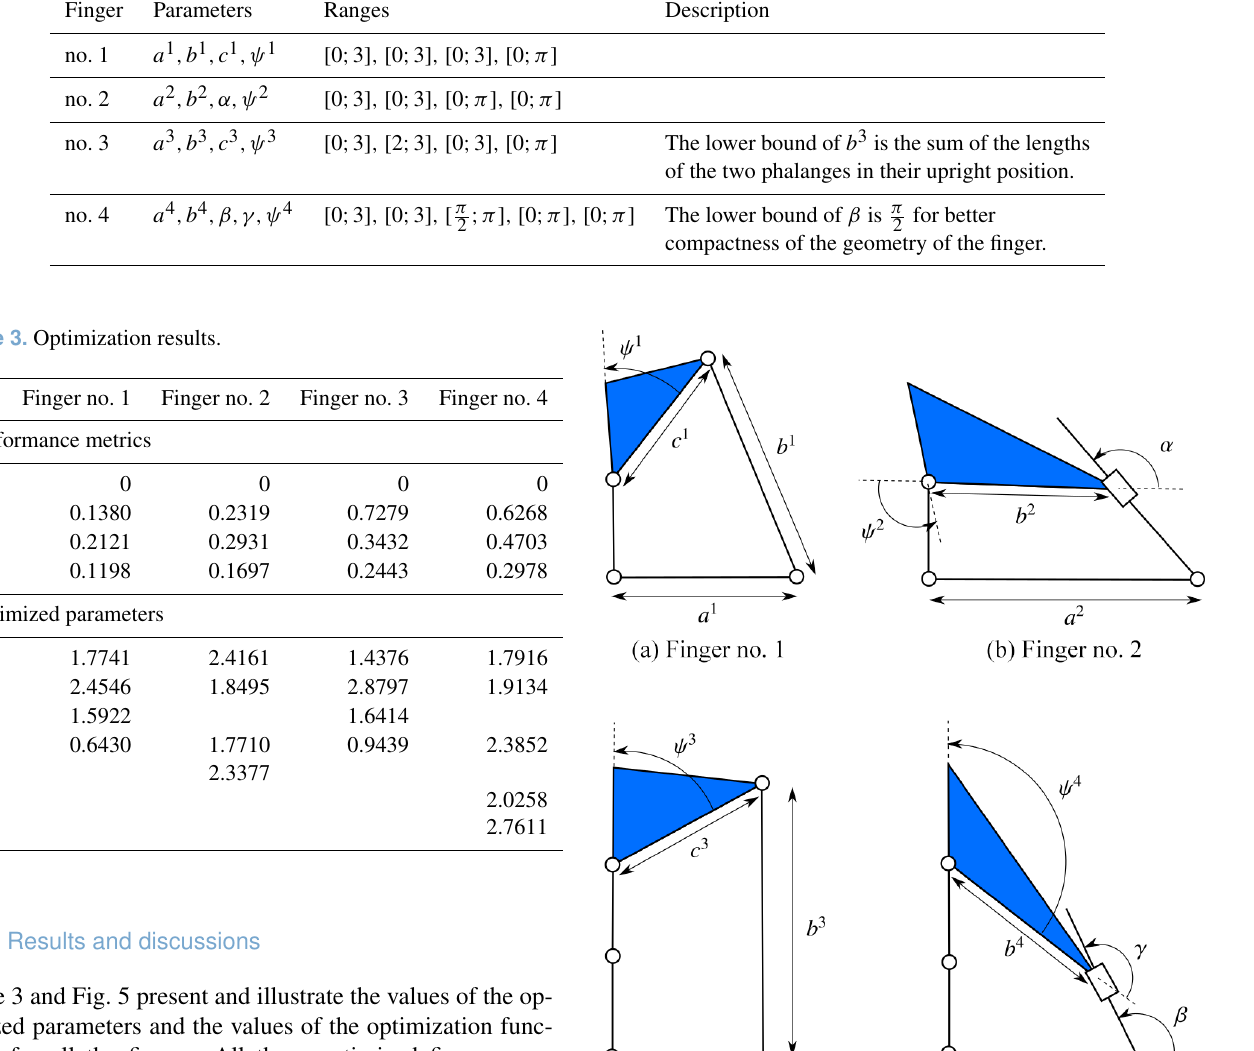
Table 2. Geometrical parameters of the fingers to be optimized. Finger Parameters Ranges Description no. 1